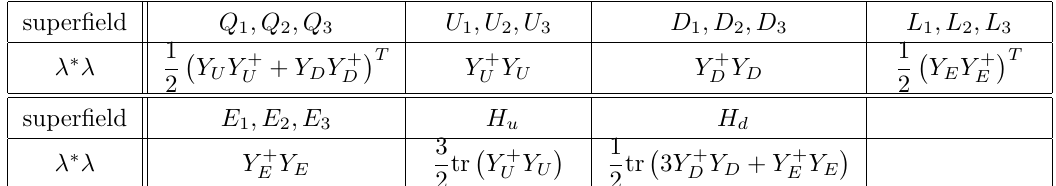
Table 3 . Values of ( λ ∗ λ ) ab for various MSSM superfields. The nondiagonal elements of this matrix can be nontrivial only if a and b correspond to the same superfields of different